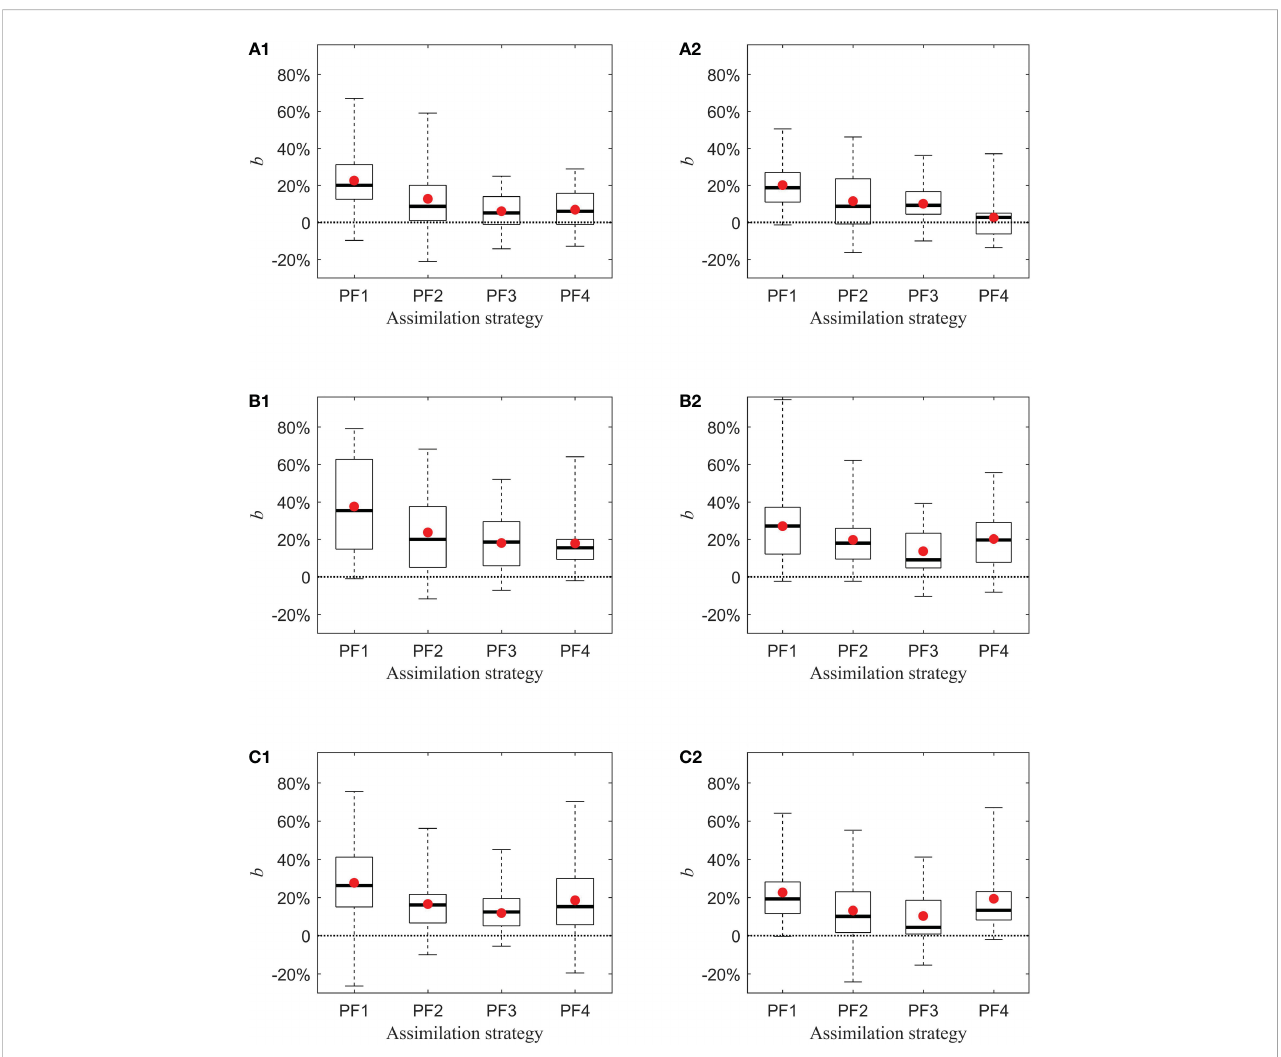
FIGURE 4 The box plots of b of PF1, PF2, PF3, and PF4 in the upstream (1) and downstream (2) of the KE, with respect to selected eddies and 10 groups of observations for each area. (A – C) For the LICOM model data, GLORYS2V4 data, and AVISO data,